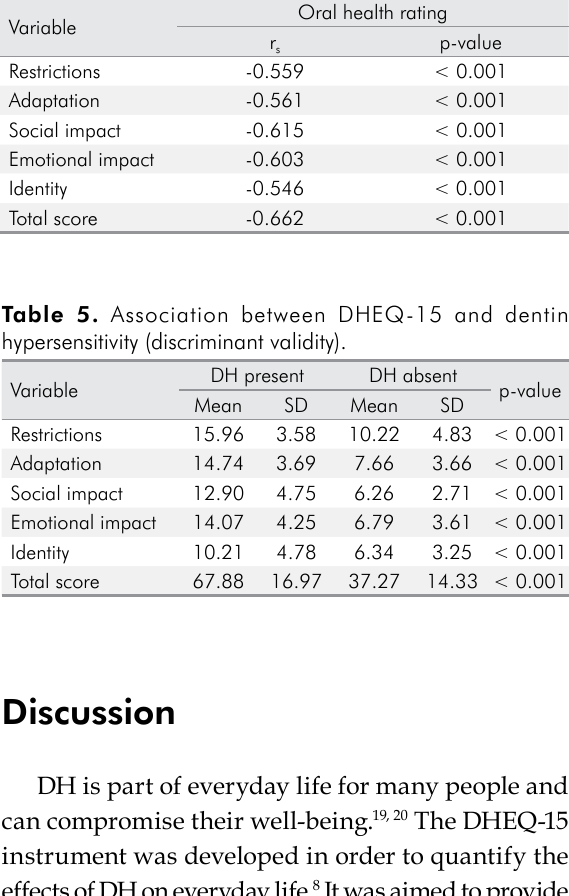
Table 4. Correlation between DHEQ-15 and global rating of oral health (convergent validity).